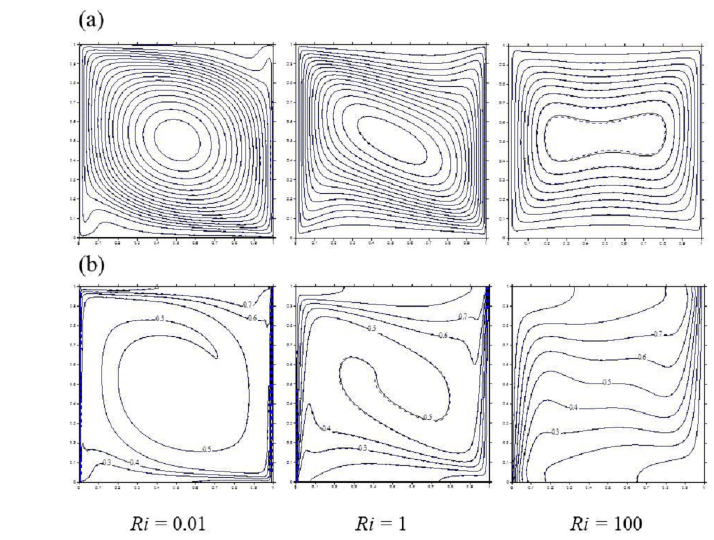
Figure 2: Streamlines (a) and Isotherms (b) for different values of the Richardson number. ϕ = 0.02 , [ —- Cu-water, — Ag-water ].